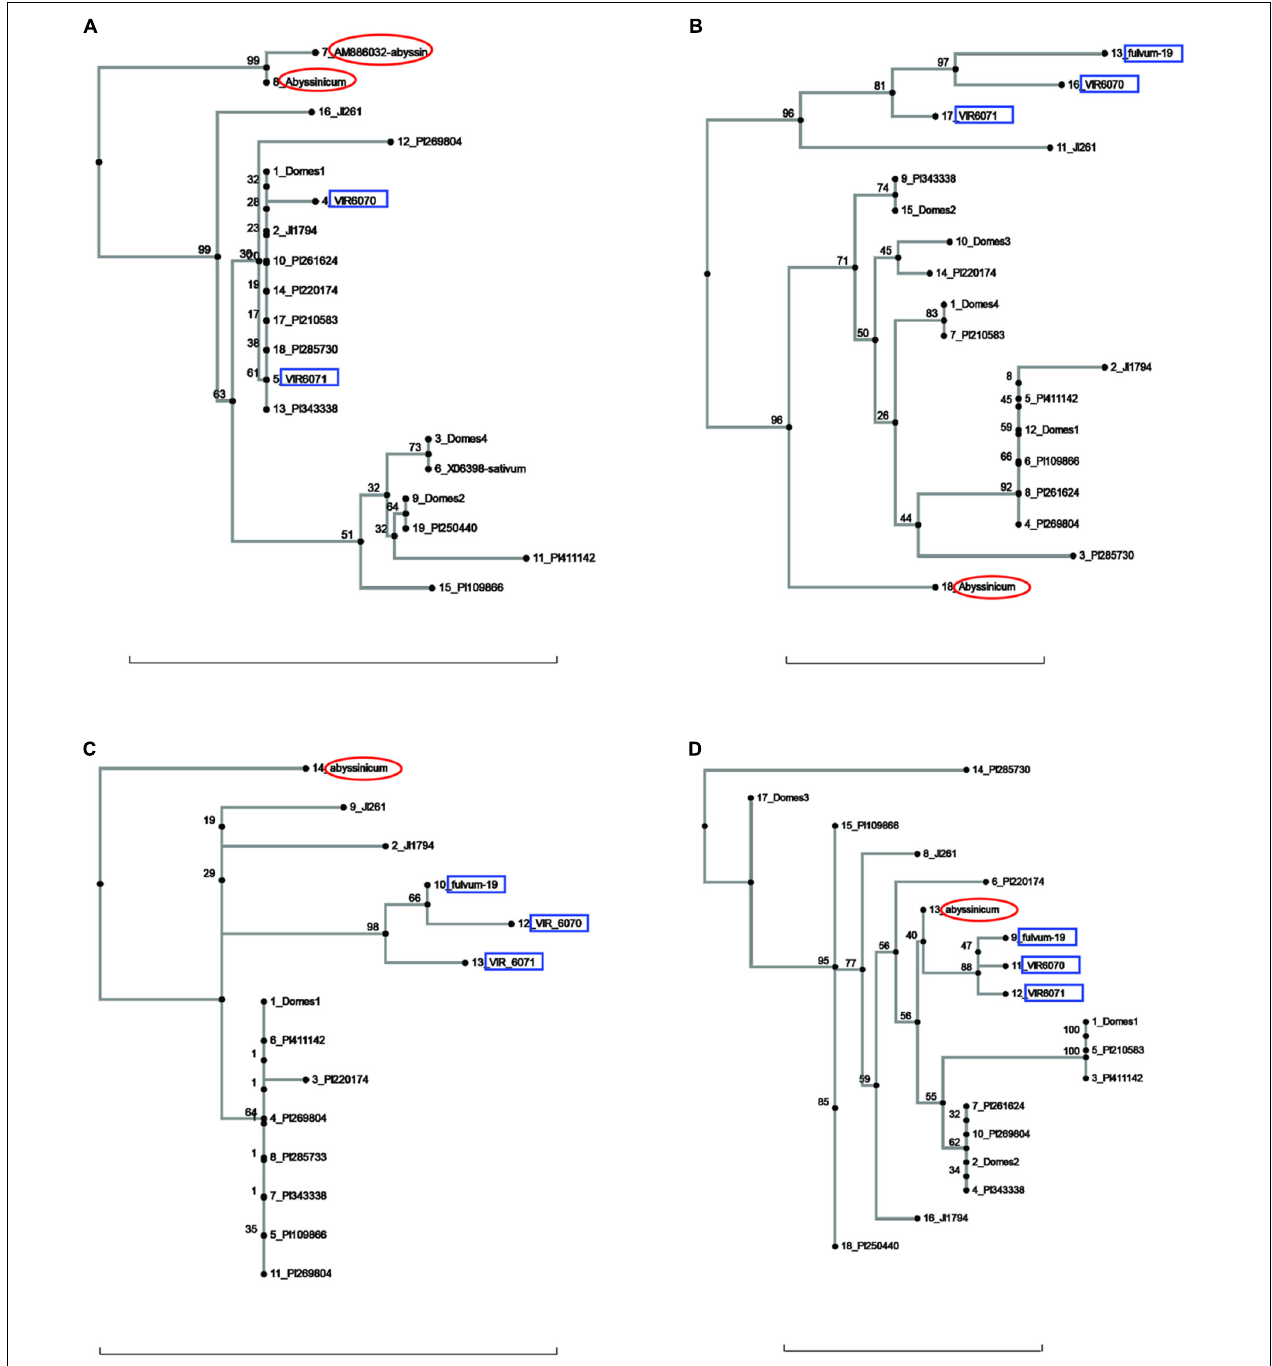
FIGURE 2 | Phylogeny trees of the alleles for (A) Cvc , (B) Gib2ox , (C) Er1 , and (D) Skdh . The position of the allele from P. sativum ssp. abyssinicum is circled in red, those for P. fulvum accessions are boxed in blue. The position of each PI accession is presented individually, but those for the modern varieties are lumped into groups labeled Domes1, Domes2, etc. Bar at base of each cladogram represents a nucleotide substitution rate of 0.01.